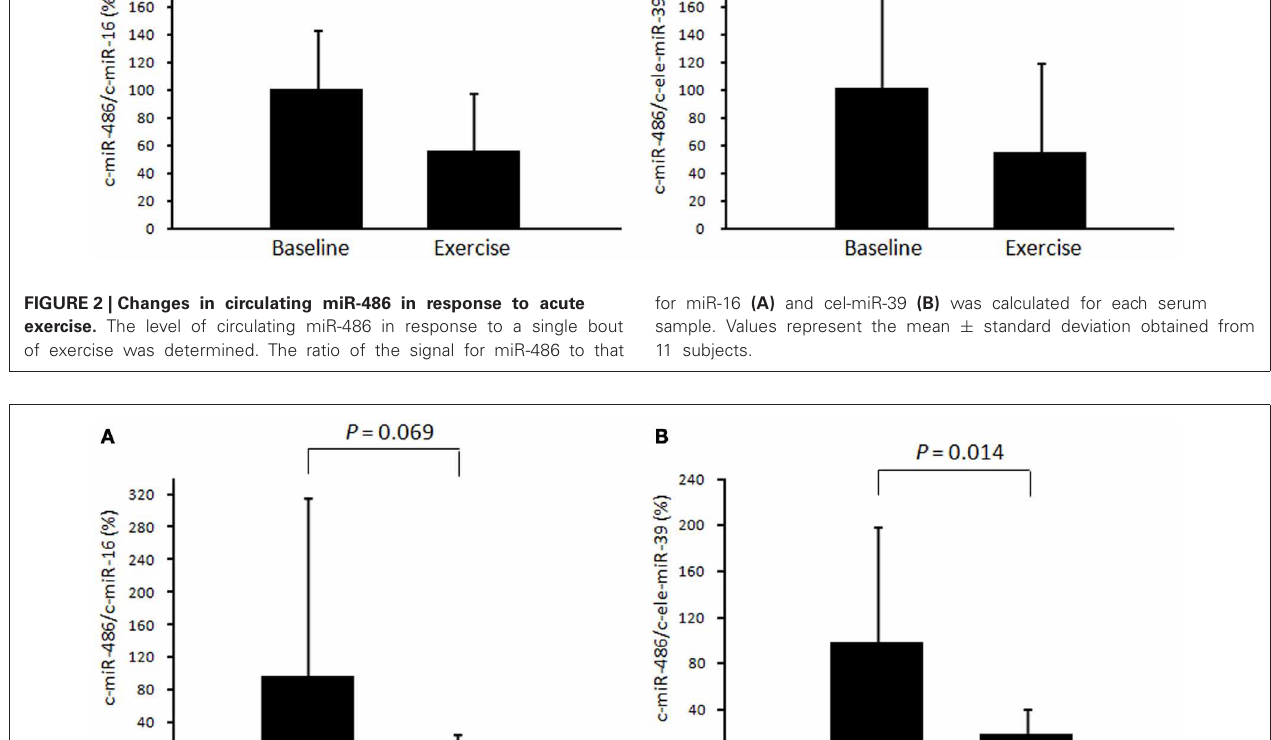
FIGURE 3 | Changes in circulating miR-486 in response to chronic exercise. The level of circulating miR-486 in response to 4 weeks of exercise training was determined. The ratio of the signal for miR-486